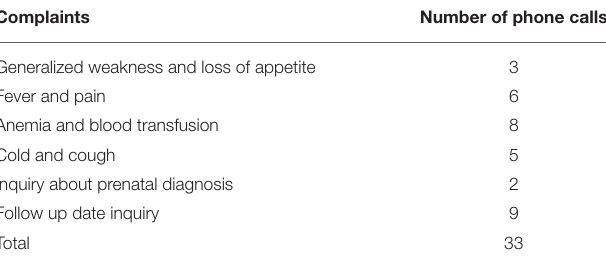
TABLE 4 | Number of phone calls received from the parents of the affected babies for different complaints.